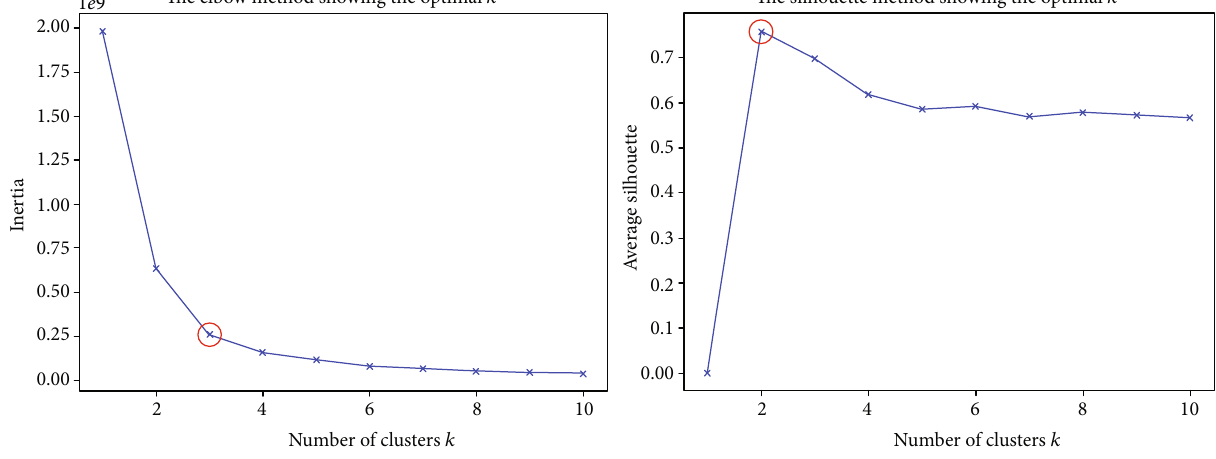
Figure 8: Optimal number of clusters suggested by the elbow and the average silhouette methods.